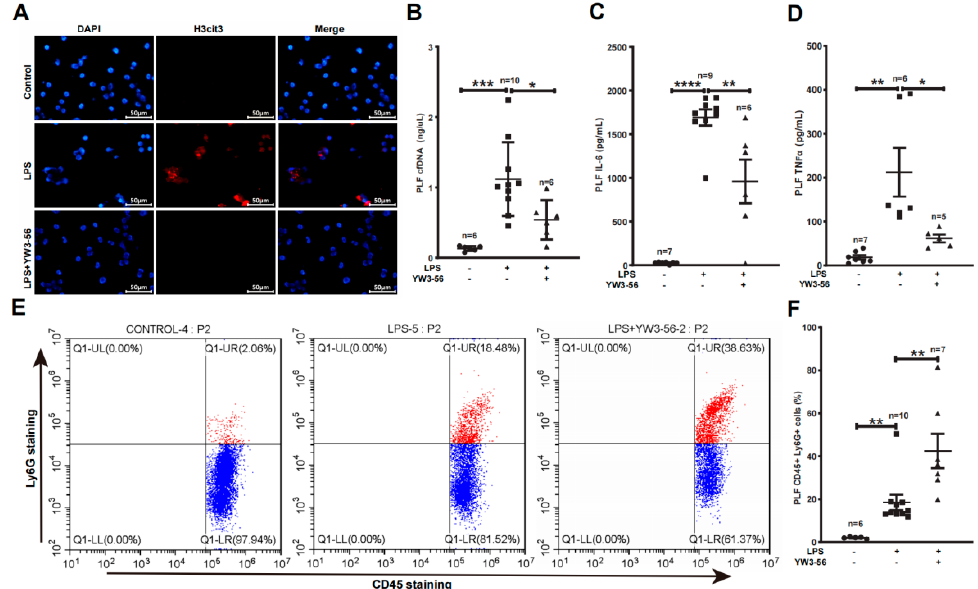
Figure 3. PAD inhibitor YW3-56 decreased netosis, cfDNA, IL-6 and TNF α levels and led to a high amount of neutrophil accumulation in peritoneal cavity. ( A ) After LPS treatment, neutrophils obtained from peritoneal lavage fluid (PLF) showed an increased histone citrullination (red) and netosis as detected by immunostaining with a histone H3Cit (Cit2, 8, 17) antibody and DNA dye DAPI staining (blue). NET formation and histone citrullination were decreased upon YW3-56 treatment. ( B − D ) PLF cfDNA ( n = 6, 10, 6 in each group) ( B ), IL-6 ( n = 7, 9, 6 in each group) ( C ) and TNF α ( n = 7, 6, 5 in each group) ( D ) levels were much increased after LPS treatment, while YW3-56 treatment significantly decreased cfDNA, IL-6 and TNF α levels. ( E , F ) Percentage of neutrophils ( n = 6, 10, 7 in each group) (CD45+ and Ly6g+) was significantly increased after LPS treatment, while YW3-56 treatment further neutrophil percentage. Scale bars represent 50 μ m. All data in figures were presented as mean ± SEM. * p < 0.05; ** p < 0.01; *** p < 0.001; **** p < 0.0001. IL, interleukin; TNF, tumor necrosis factor; NET, neutrophil extracellular trap; cfDNA, cell free DNA; LPS, lipopolysaccharides; PLF, peritoneal lavage fluid.